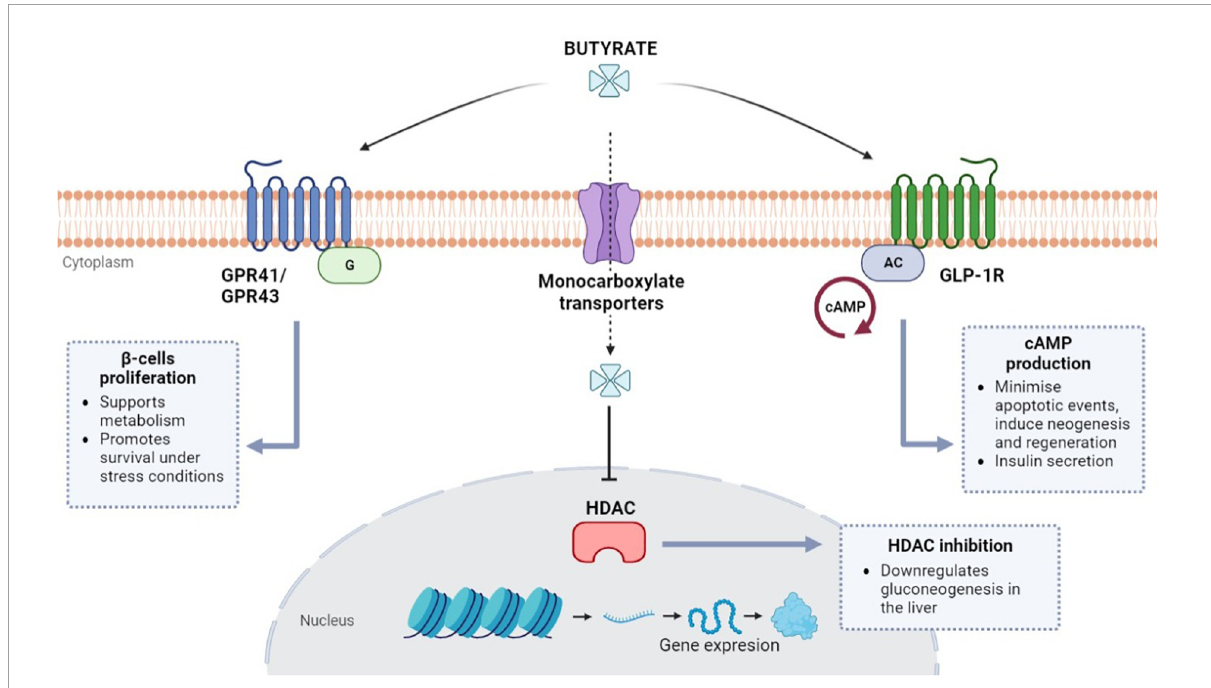
FIGURE1 Butyrate regulation pathways in β -cells (pancreatic islets). Butyrate is involved in β -cells metabolism via G protein-coupled receptors (GPRs) GPR41 and GPR43. Butyrate can also enter the cells via monocarboxylate transporters and inhibit histone deacetylases (HDAC) which are thought to be involved in gluconeogenesis signaling. Butyrate can also regulate the cAMP signaling for insulin secretion via glucagon-like peptide-1 receptors (GLP-1R).